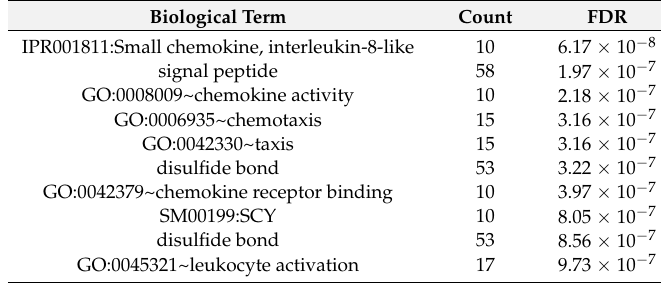
Table 6. FDR-ranked top 10 biological terms significantly enriched in the set of 166 DE-genes when comparing the expression profile for 499 genes between MSS vs. MSI-high and EBV+ vs. EBV − GC